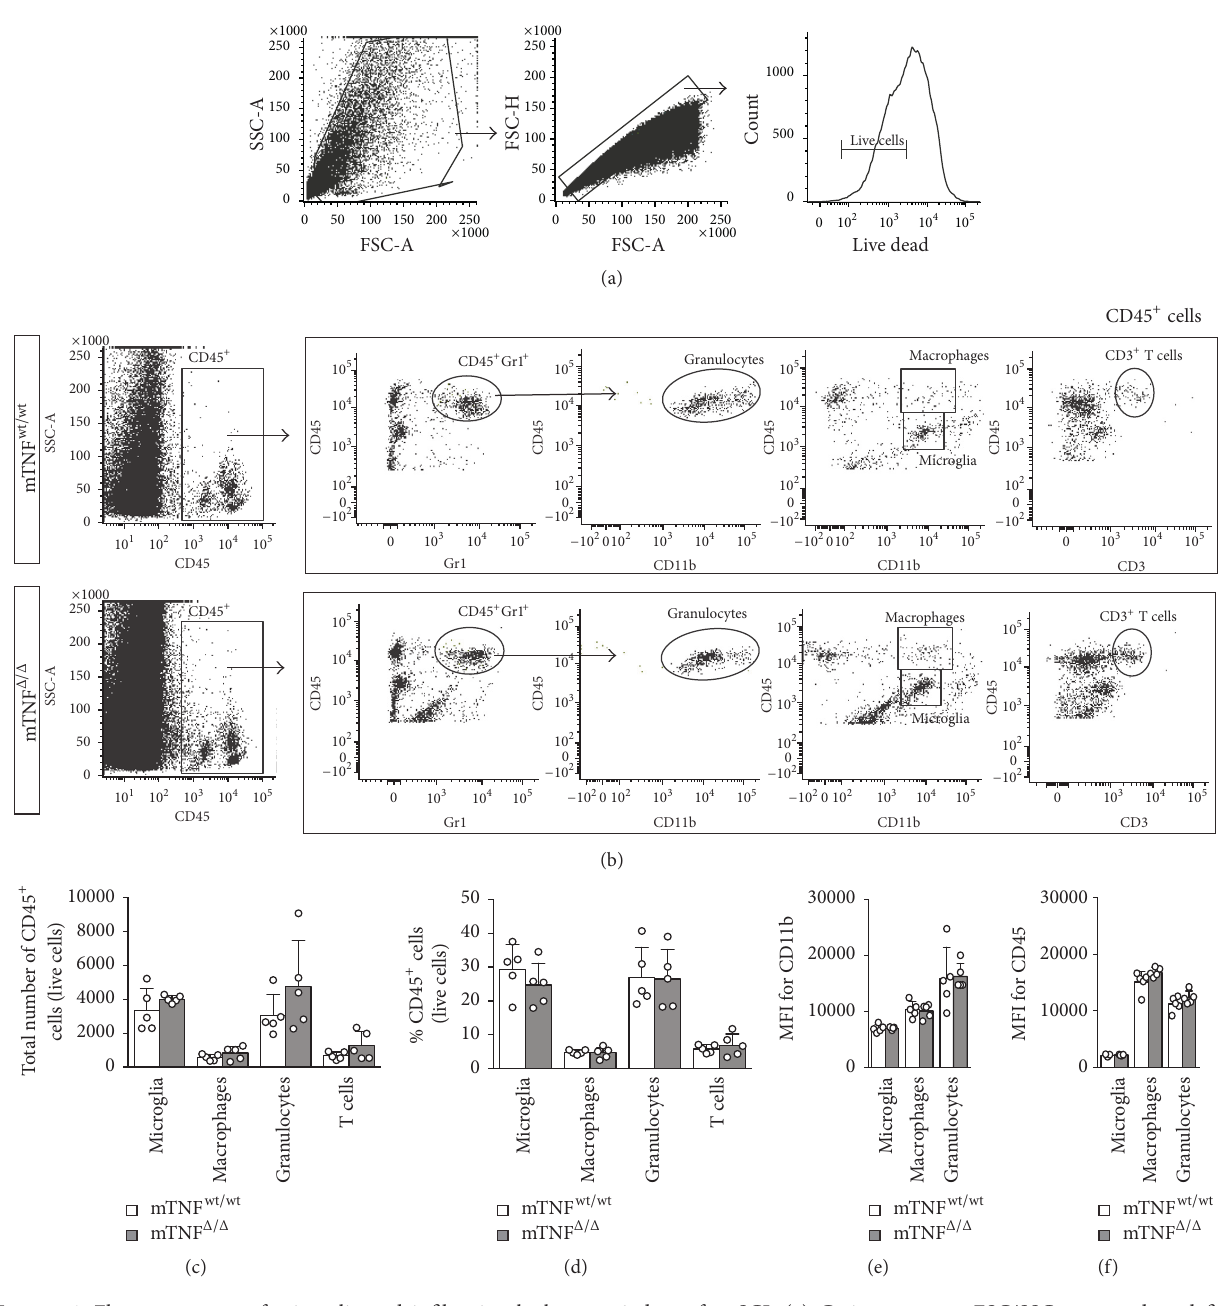
Figure 4: Flow cytometry of microglia and infiltrating leukocytes 3 days after SCI. (a) Gating strategy: FSC/SSC was used to define cell populations. Singlet cells were identified using FSC-A/FSC-H, and only live cells were included. (b) Representative flow cytometry plots comparing macrophage, granulocyte, and T cell infiltration in mTNF wt / wt and mTNF Δ/Δ mice. (c, d) Number (c) and percentage (d) of microglia (CD11b + CD 45 dim ), macrophages (CD11b + CD 45 dim Gr1 − ), granulocytes (CD11b + CD 45 dim Gr1 + ), and T cells (CD45 + CD3 + ) in mTNF wt / wt and mTNF Δ/Δ mice 3 days after SCI. Results are expressed as mean ± SD, 𝑛 = 5 mice/group, Mann–Whitney